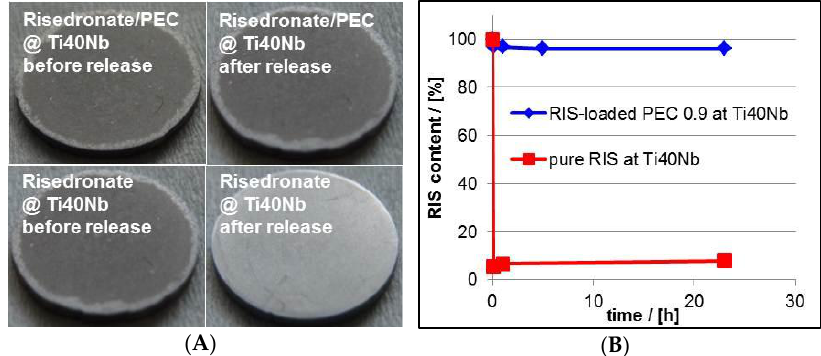
Figure 15. ( A ) Photographs of RIS/PEC- and RIS-modified Ti40Nb alloy plates before and after release experiment (PEC: PLL/CS-1.0). ( A ) Release kinetics of RIS from RIS/PEC modified Ti40Nb alloy plates measured by UV/VIS spectroscopy ( B ).